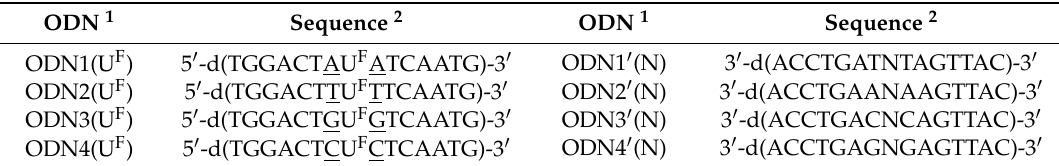
Table 1. Quencher-free linear